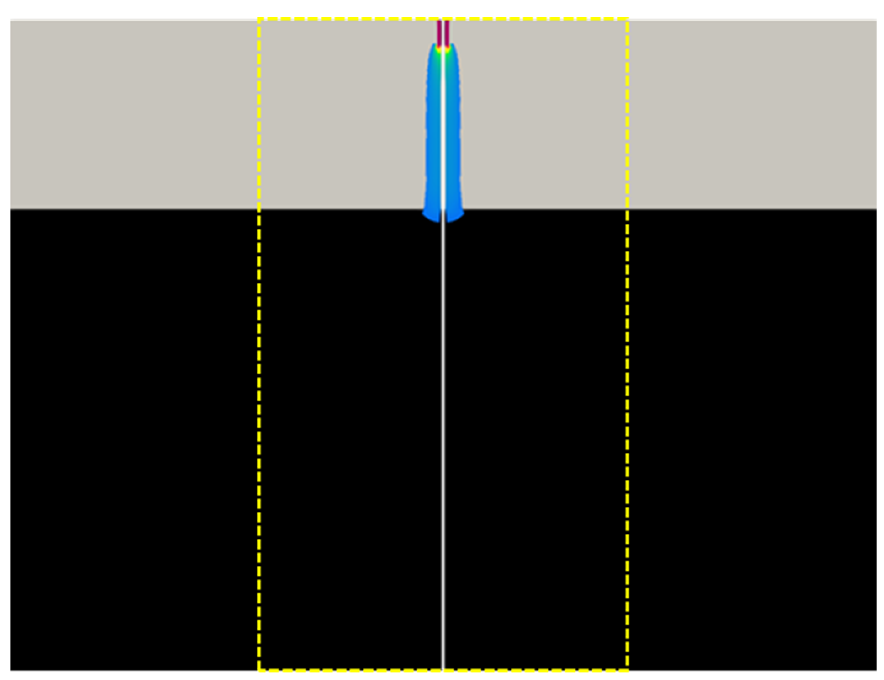
Figure 12. The zoomed domain is enlarged (yellow frame) due to a deeper arc impingement.